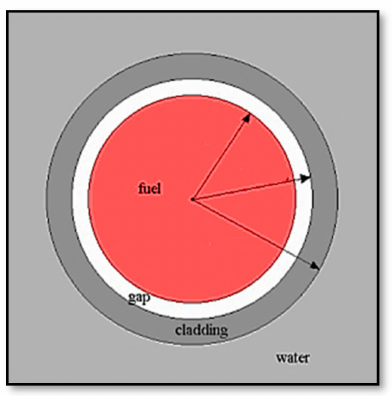
Figure 5. Fuel pin unit cell cross sectional view.